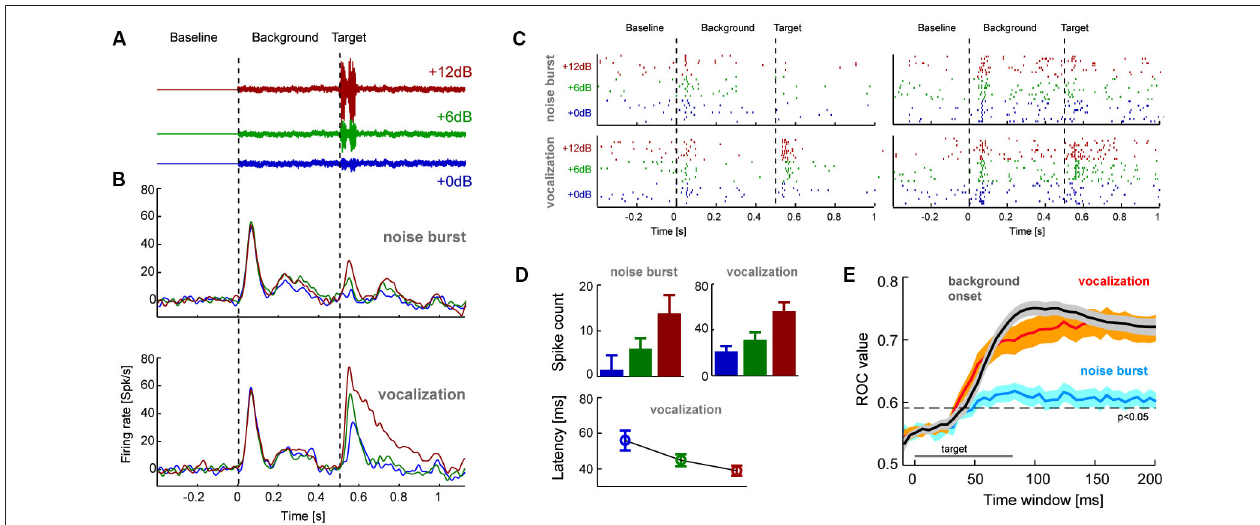
ms), and response latency for vocalization targets. Error-bars denote mean and s.e.m. (E) Results from a single trial sound detection analysis quantified by receiver operator characteristic (ROC) scores (area under the ROC curve). Lines denote the mean and shaded areas the s.e.m. across units for each target type and the onset of the background sound. Time is indicated relative to the event-onset (either background or target sound) and the ROC scores are based on the cumulative response amplitude in the respective window duration. The indicated significance level (relative to chance performance) was obtained from a randomization